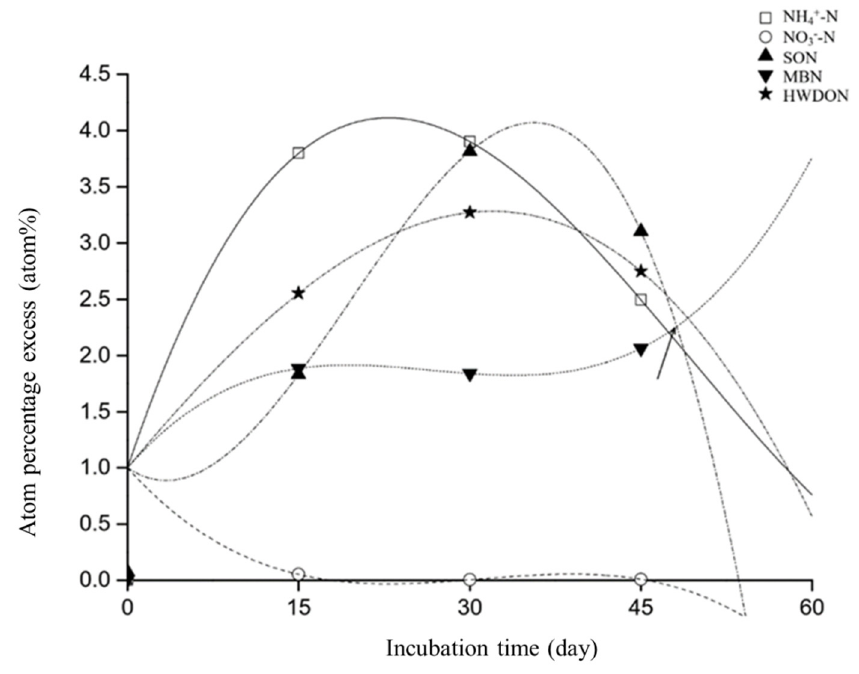
Figure 4. Nitrogen atom percent excess (APE) of available nitrogen fractions in compost. The arrow in the figure indicates that all available nitrogen fractions of the compost were labeled homogeneously, and the average APE was 2.36% at day 48.